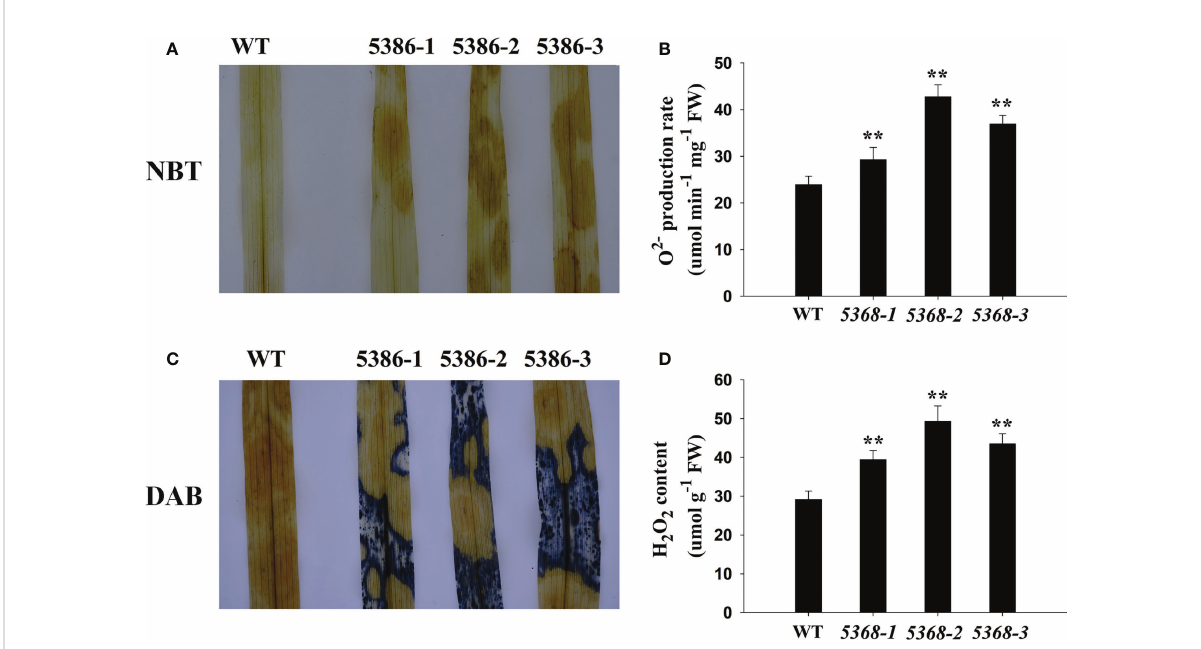
FIGURE 5 Changes in reactive oxygen species (ROS) accumulation in fl ag leaves in WT and LMM 5386 lines. (A) NBT staining results for O (cid:129) − 2 ; (B) O (cid:129) − 2 production rate; (C) DAB staining for H 2 O 2 ; (D) H 2 O 2 content. Values are means ± SD of three replicates. Error bars indicate standard deviations. **P < 0.01.